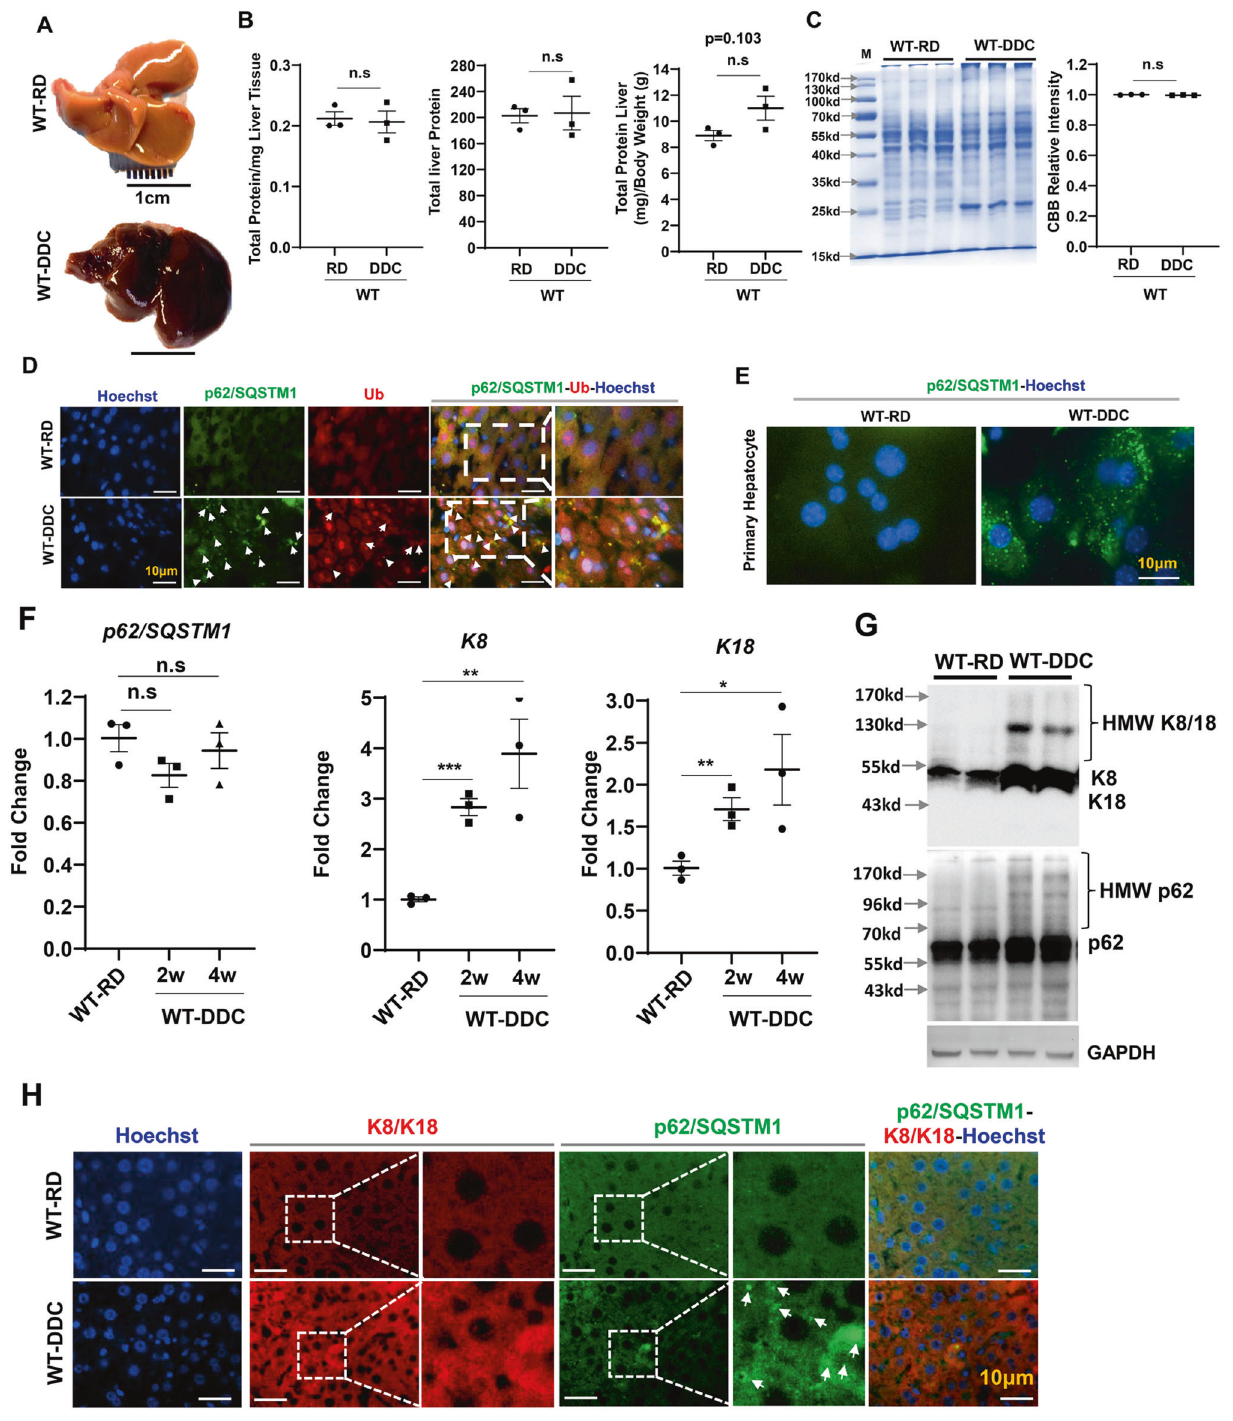
Fig. 1 Hepatic proteins are altered qualitatively but not quantitatively by DDC. A Gross image of liver harvested from wild type mice fed with regular diet (RD) and 2 weeks of DDC diet. B Hepatic total protein level in 9-week-old mice wild type mice fed with RD and 2 weeks of DDC diet. C Total liver lysates from 9-week-old mice were analyzed by CBB staining. Protein band intensities were quanti fi ed by densitometry. D Liver sections were stained for p62/SQSTM1 and Ubiquitin (Ub). Arrows indicate hepatocytes without aggregated p62 or Ub. Scale bars: 10 μ m. E Immunostained for p62 in primary hepatocytes isolated from 9-week-old wild type mice fed with RD and 2 weeks of DDC diet. F Quantitative PCR analysis for p62, K8, and K18 mRNA expression in 9-week-old mice wild type mice fed with RD and 2 – 4 weeks of DDC diet. The mRNA expression levels were normalized to actin. G Total liver lysates from 9-week-old mice were analyzed by immunoblotting for K8/18, p62 and GAPDH. Data are expressed as the mean ± SEM. n.s not signi fi cant, * P ≥ 0.05, ** P ≥ 0.01, *** P ≥ 0.001 ( n = 3). H Liver sections were co- stained for K8/K18 and p62. Arrows indicate hepatocytes without aggregated p62. Scale bars: 10 μ m.